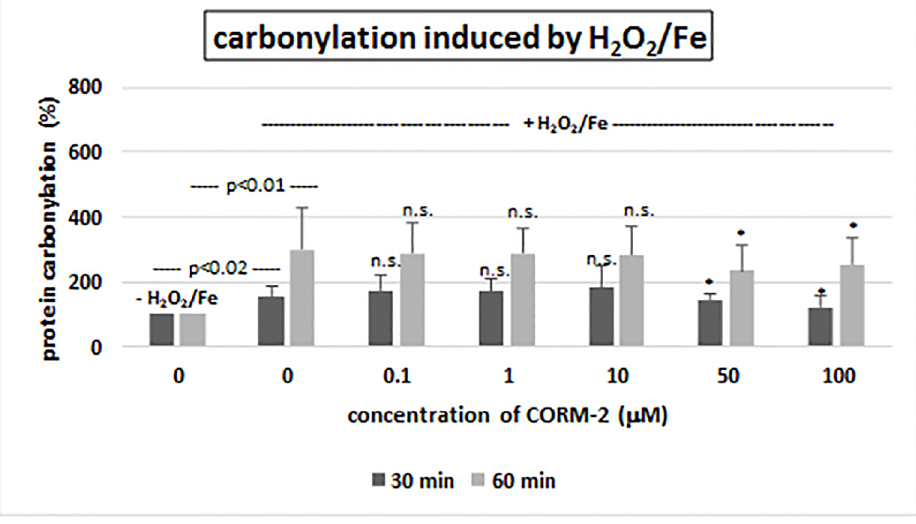
Fig 4. The effect of CORM-2 (0.1–100 μ M, incubation time– 30 and 60 min) on carbonyl group formation (plasma protein oxidation) induced by H 2 O 2 /Fe. Data representsmeans ± SD of 6 experiments (from different donors). * p < 0.05 vs . control (+ H 2 O 2 /Fe), n.s. p > 0.05 vs . control (+ H 2 O 2